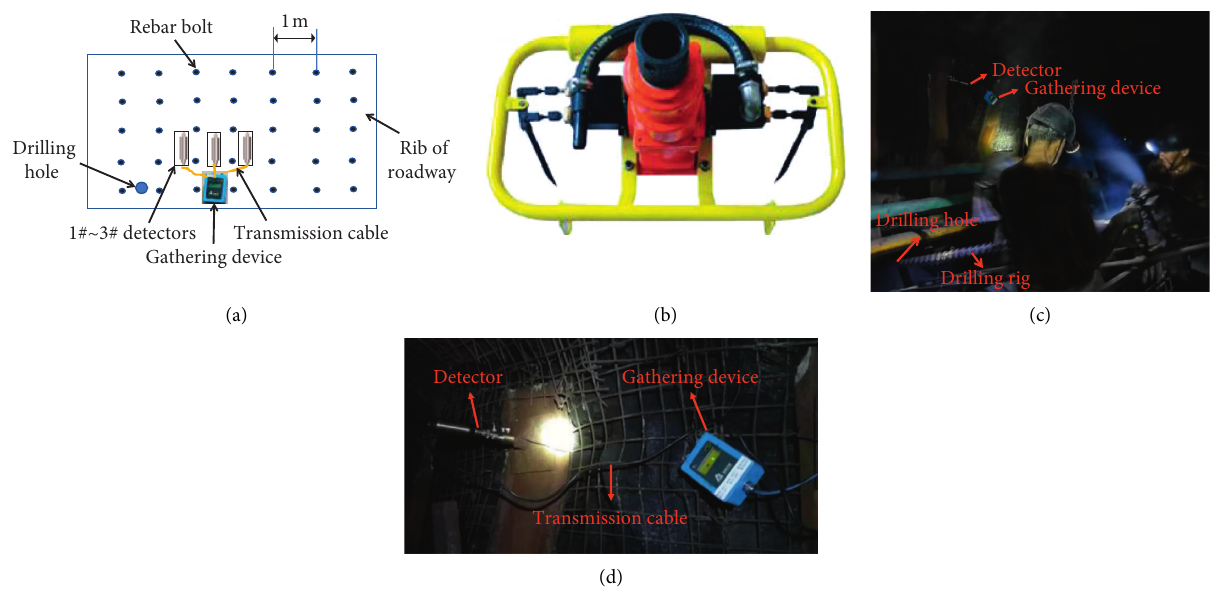
Figure 1: Test equipment and arrangement. (a) Test arrangement. (b) Hand-held pneumatic drilling rig. (c) Construction site. (d) Site